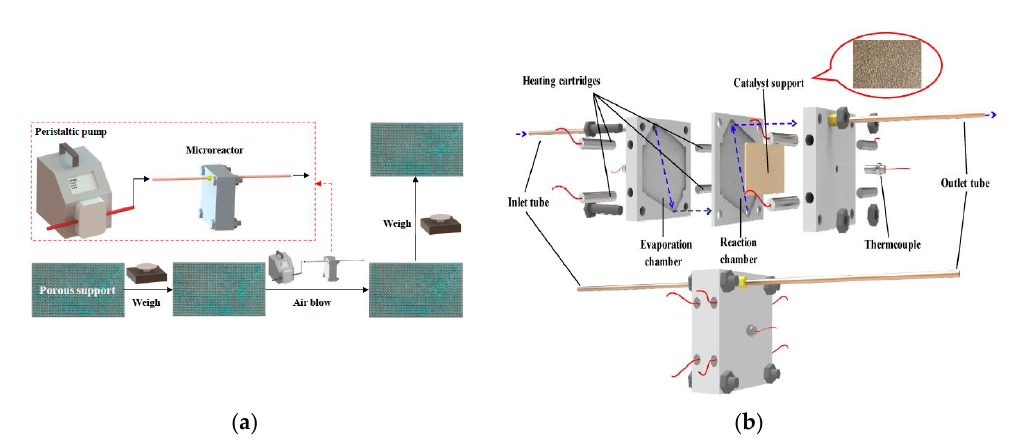
Figure 20. ( a ) Catalyst loading strength measurement starts by blowing dry air onto the loaded support and ends with weighing it to measure the weight difference. ( b ) Illustration of plate microreactor for methanol SR for hydrogen production. Reproduced with permission from